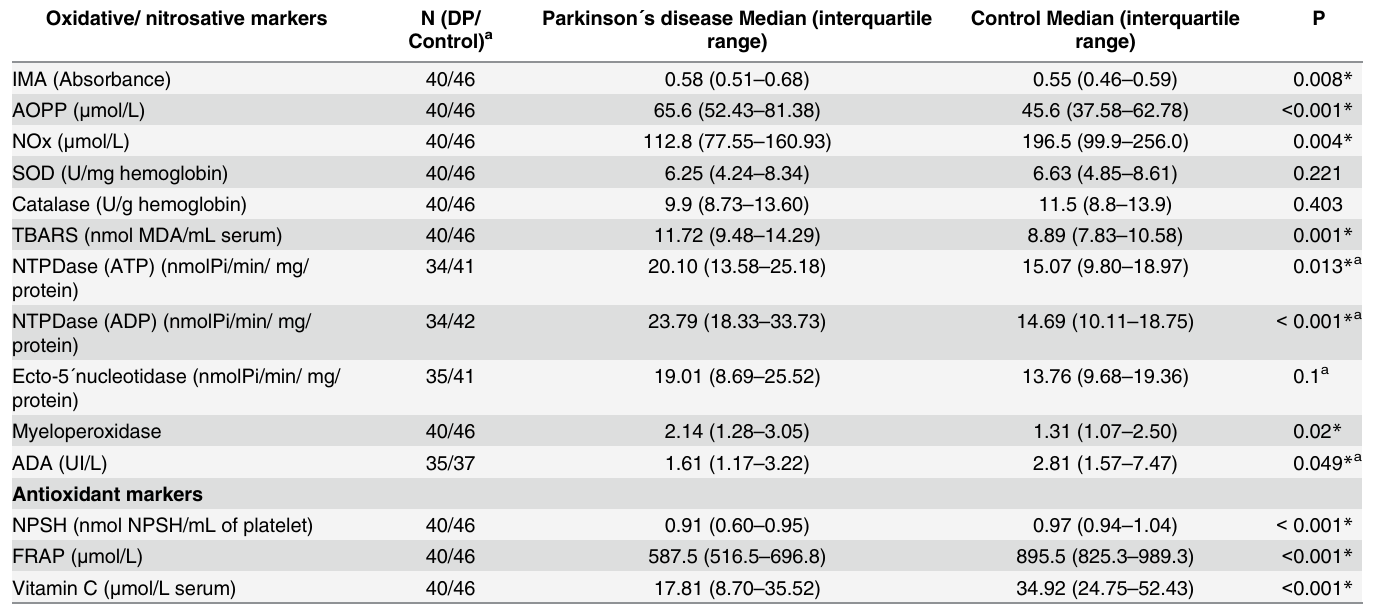
Table 3. Comparison of oxidative stress and antioxidant peripheral biomarkers between patients with Parkinson ’ s disease and control. Oxidative/ nitrosative markers N (DP/ Control)